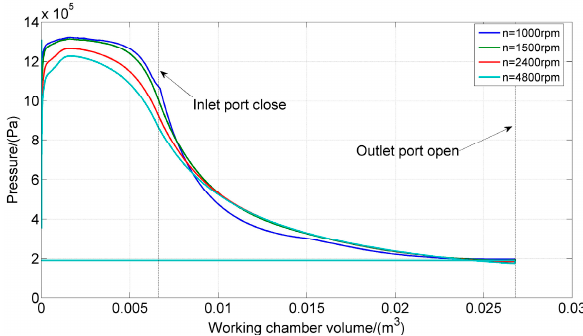
Figure 11. P ‐ V diagram for different rotate speed ( P i = 1.3 MPa, T i = 192 °C, P o = 0.19 Mpa).